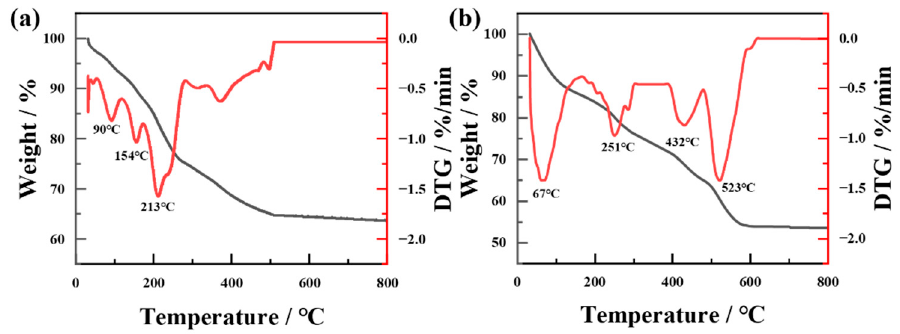
Figure 7. TG − DTG curves of ( a ) LDH and ( b ) GA −